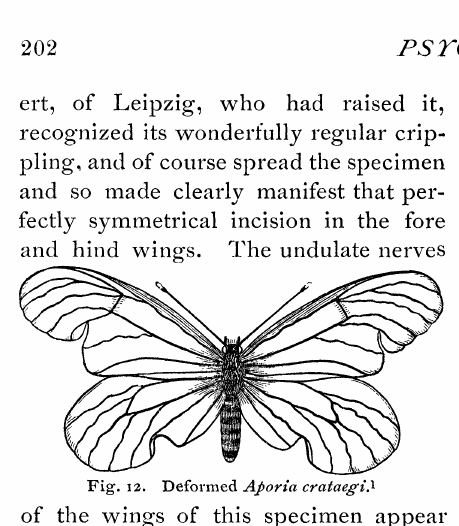
Fig. 2. Deformed Ajboria